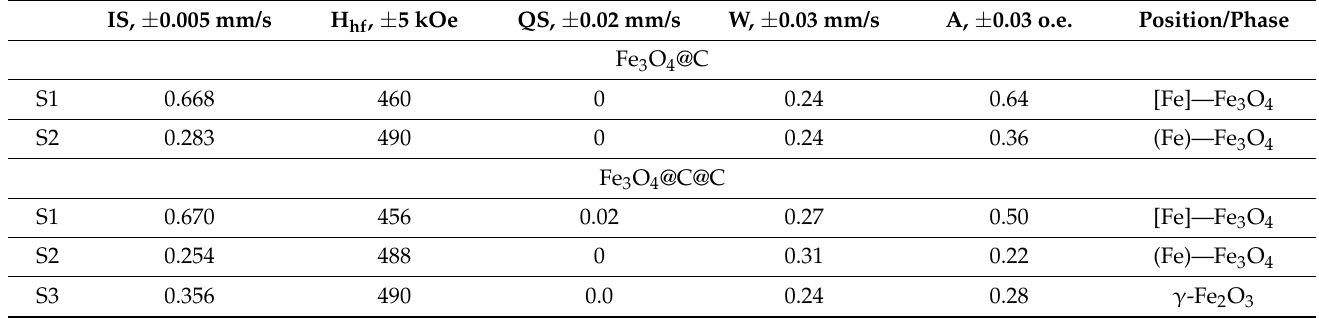
Table 1. Mössbauer parameters of the samples Fe 3 O 4 @C and Fe 3 O 4 @C@C at room temperature. IS is a chemical isomeric shift relative to α -Fe, H hf is a hyperfine field on Fe nuclei, QS is quadruple splitting, W is the width of the Mössbauer line at half-height, A is the relative occupancy of the